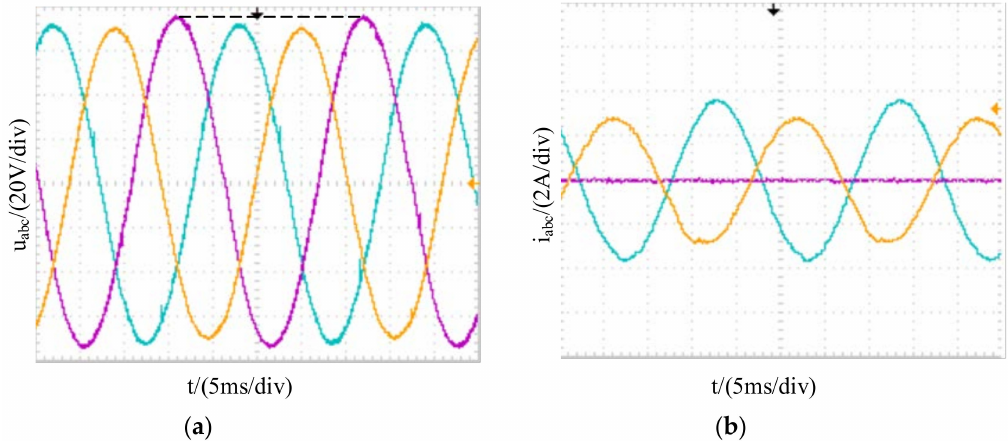
Figure 13. Experimental waveforms of three-phase output voltages and currents with traditional droop control in the case of a balanced load. ( a ) Voltage waveforms; ( b ) Current waveforms.